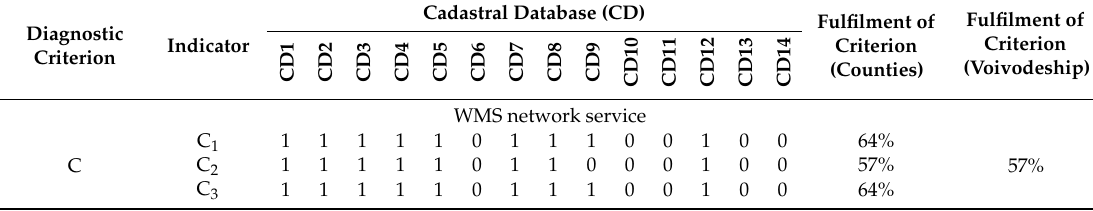
Table 11. Evaluation of Cadastral Databases Based on Criterion C.